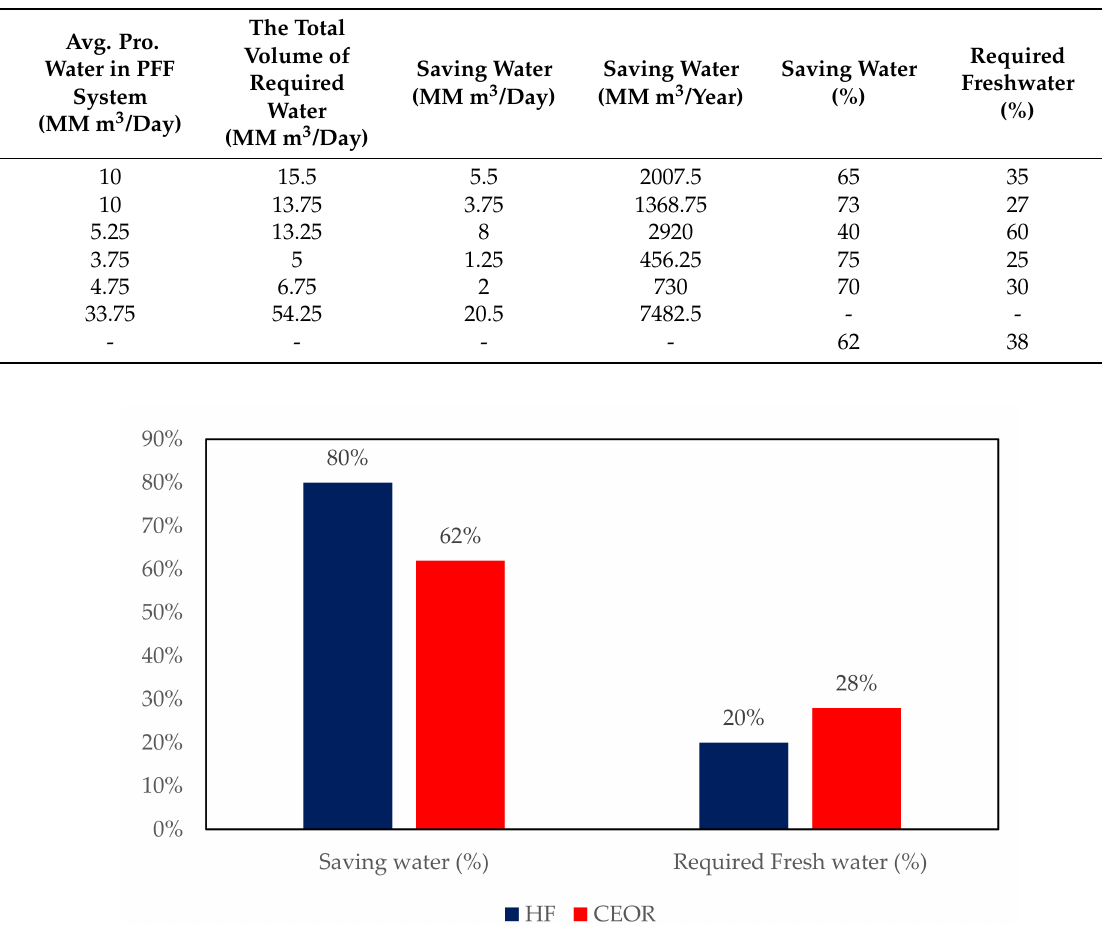
Table 2. A summary of water treatment savings for the CEOR procedure.